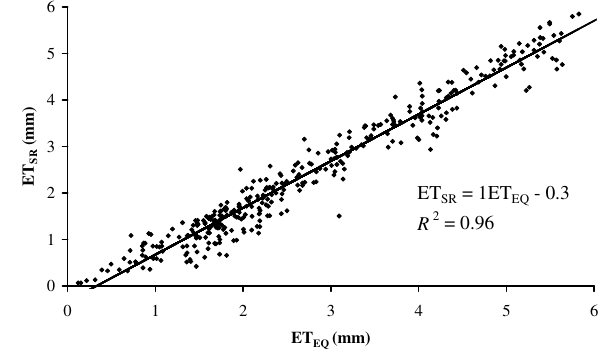
Fig. 10. The equilibrium evaporation (ET EQ ) from October 2009 to September 2010 at the Mfabeni Mire (upper line) and Embomveni Dunes (lower line). Solid lines represent fitted 95% regression quantiles and dashed lines their 95% confidence intervals.